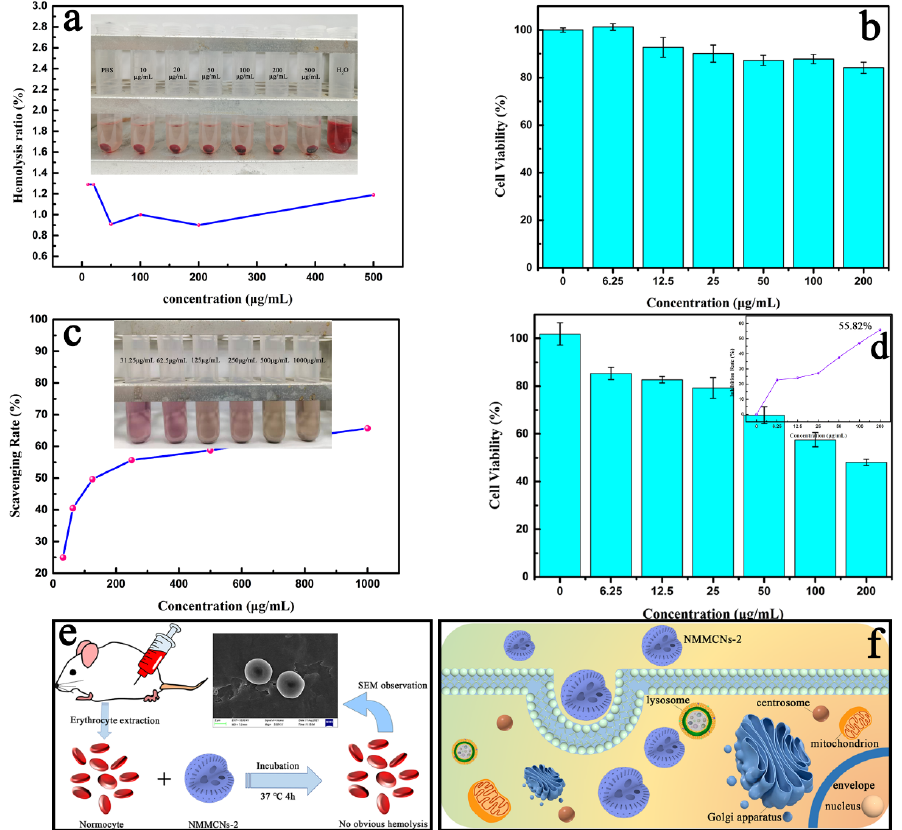
Figure 10. The hemolysis analysis ( a ) and cytotoxicity analysis ( b ) of NMMCNs-2, the in vitro antioxidation experiment analysis ( c ) and in vitro antitumor activity analysis ( d ) of Res–NMMCNs-2. The panel ( d ) inset is the analysis of the Hepa1-6 tumor cell inhibition rate of Res–NMMCNs-2 in vitro and ( e ) and ( f ) are schematic diagrams of the hemolysis experiment and cell uptake experiment, respectively.